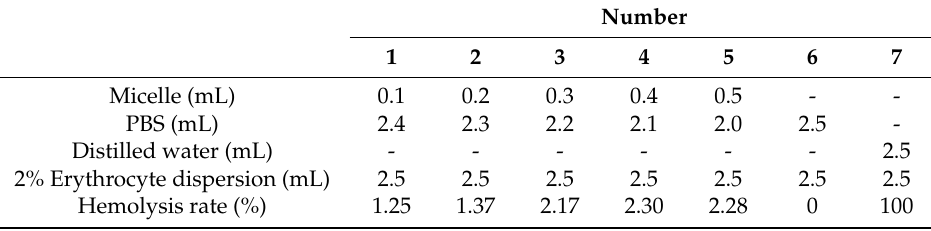
Table 1. Hemolysis rate.